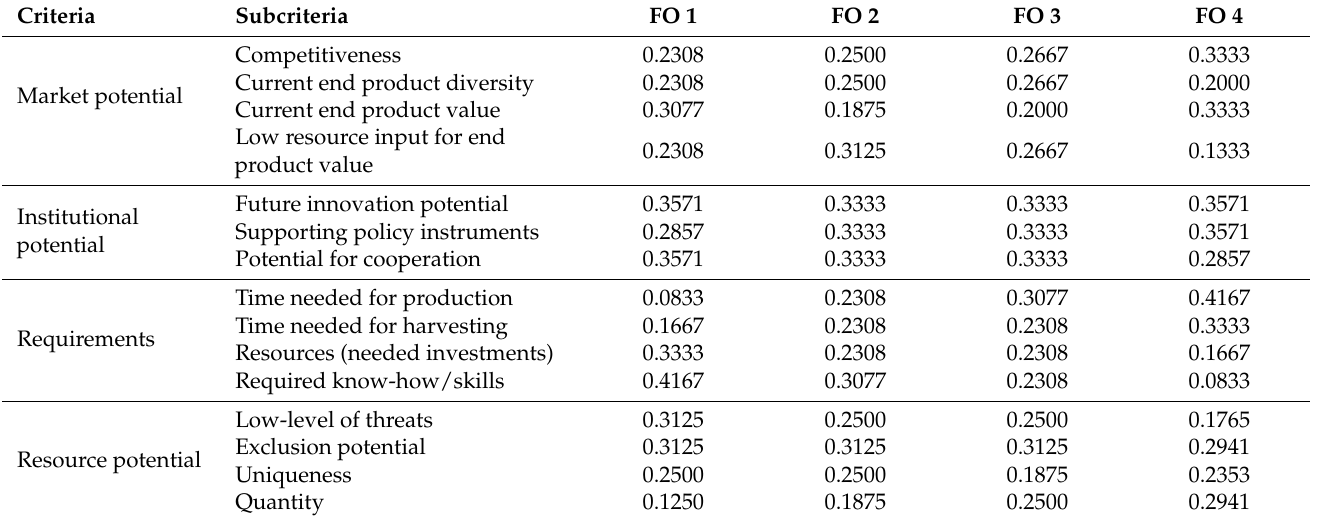
Table 3. Forest owner profiles (FO 1 = hands-on nurturer, FO 2 = part-time outsourcer, FO 3 = urban value-extractor, FO 4 = urban value-extractor without connection to forestry/agriculture) and their relative weights for the sub-criteria of the four main criteria of the decision